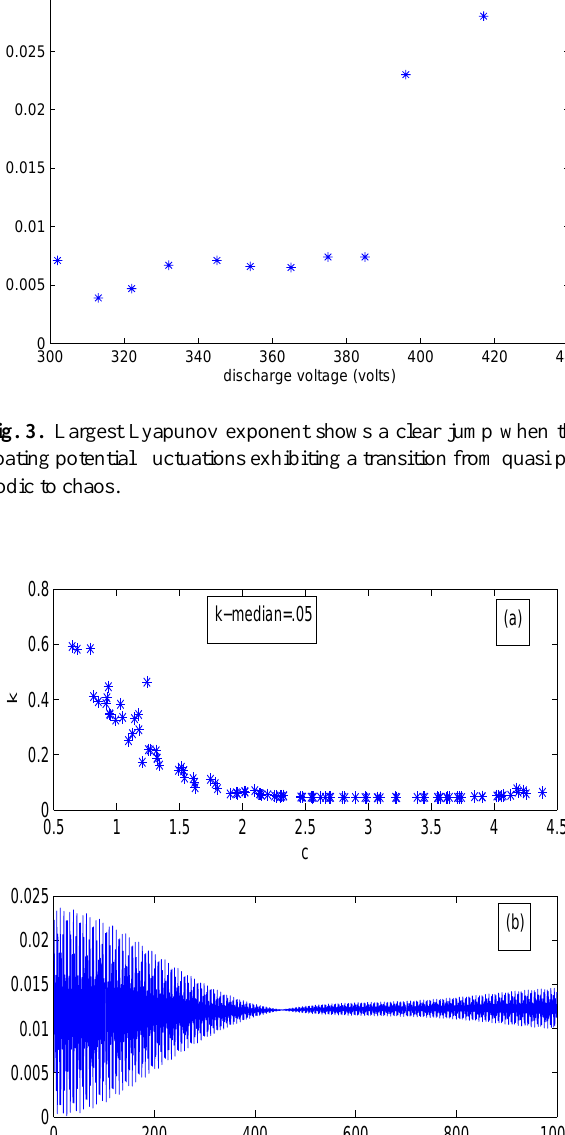
Fig. 4. (a) corresponds to the value of k as a function of c , with the median value shown in the box, and (b)is a plot of M ( n ) which shows a constant value and hence the slope is zero